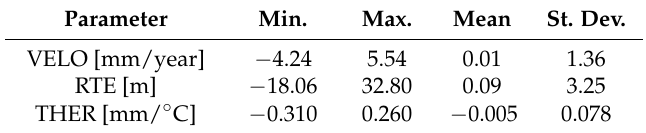
Table 1. Statistics of the results of intercomparison over the first test